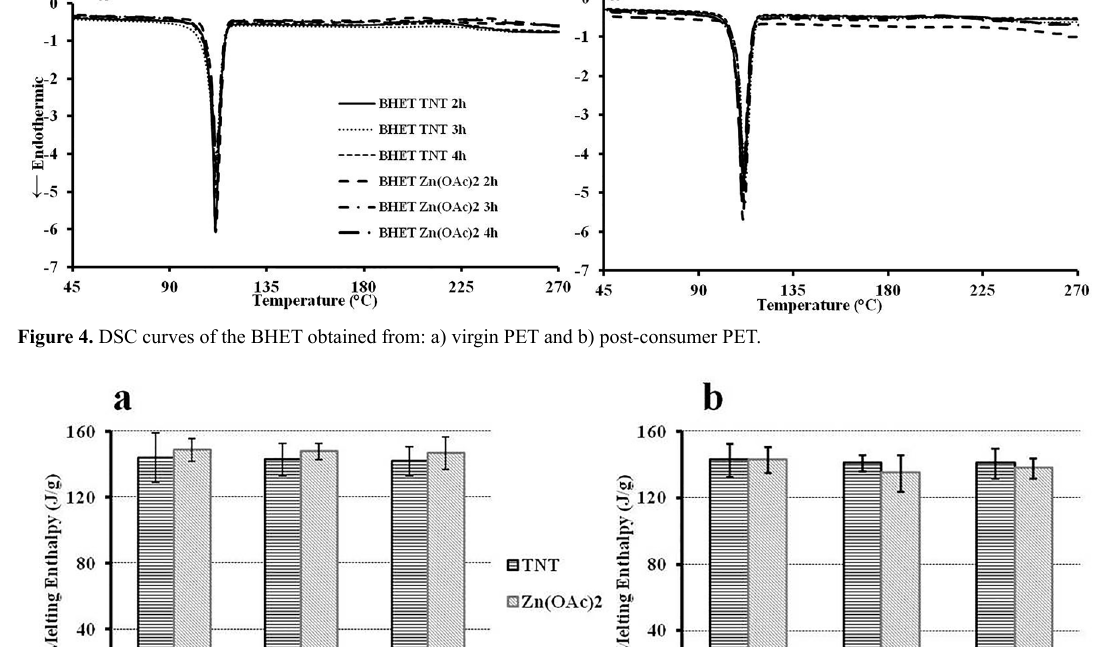
265°C) 32 , indicating that both catalysts were efficient in virgin and post-consumer PET